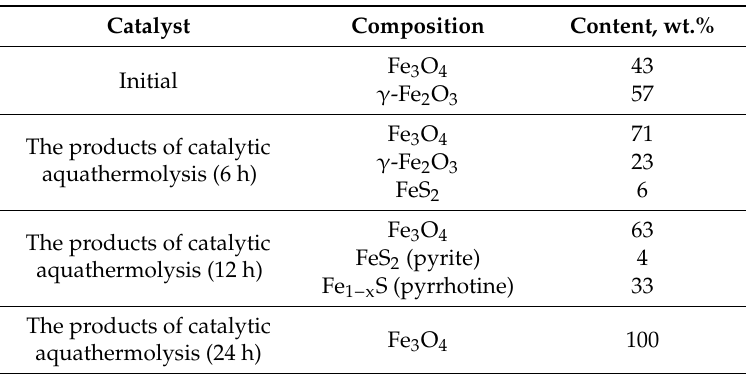
Table 2. The composition of obtained metallic oxides and sulfides at 300 ◦